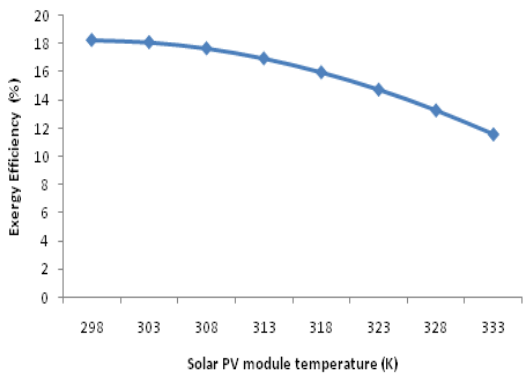
Figure 9. Variations in exergy efficiencies of solar PV module temperature